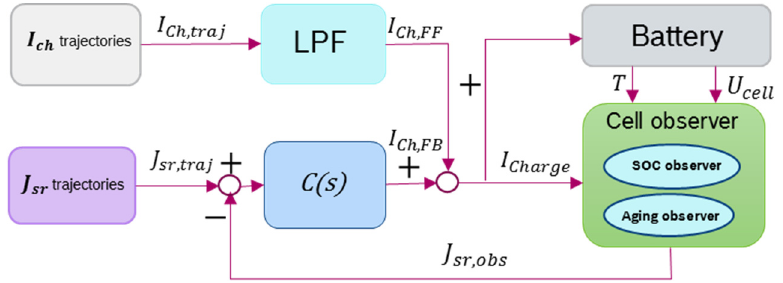
Figure 6. Fast charging control closed-loop.